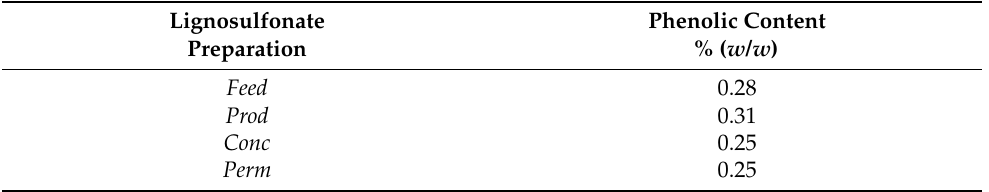
Table 2. The phenolic content of the lignosulfonate fractions.